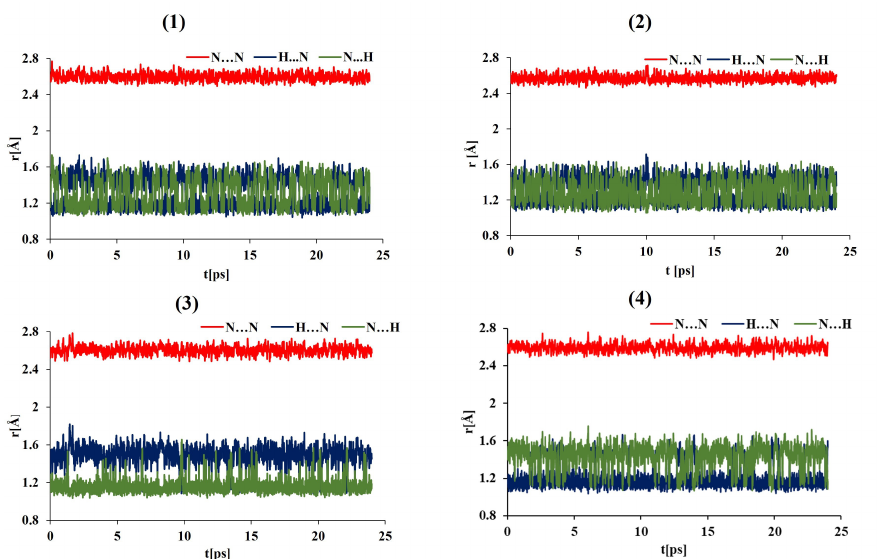
Figure 4. Time evolution of the intramolecular hydrogen bond metric parameters. Gas phase CPMD results at 100 K for DMANH + and its derivatives.